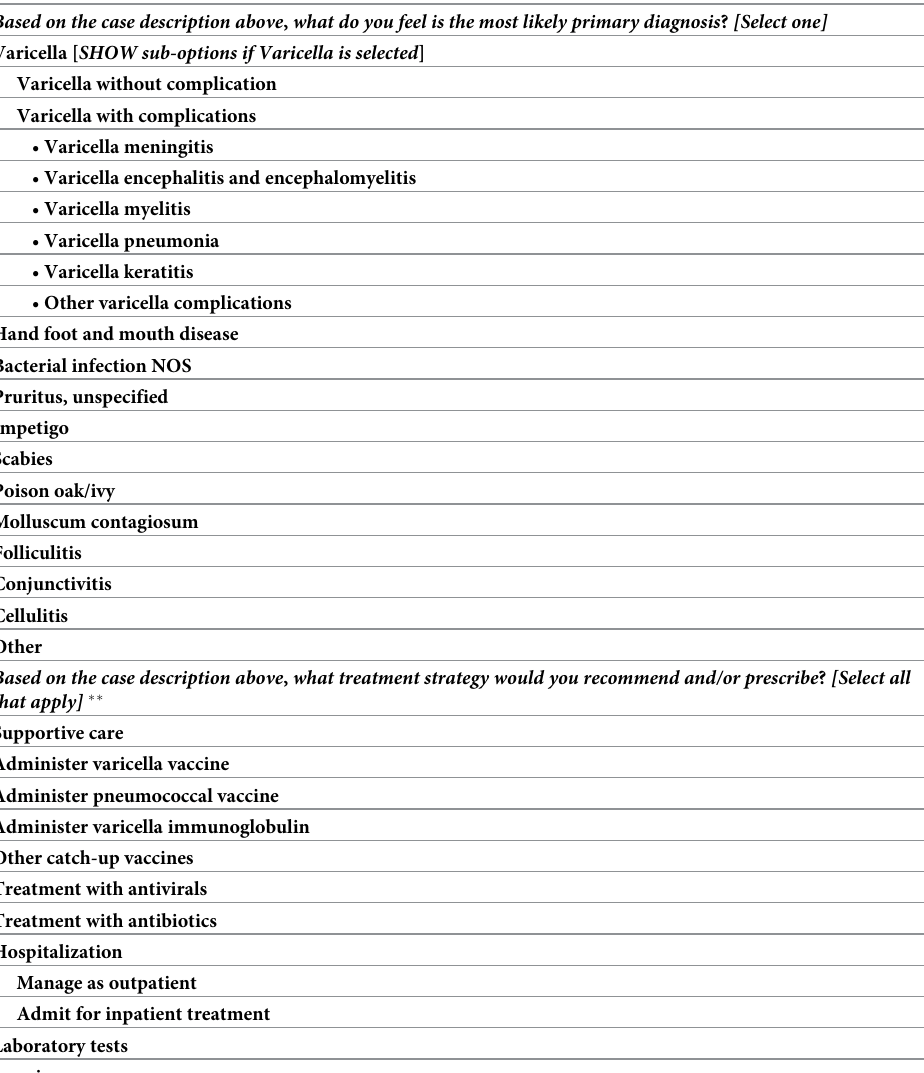
Table 1. a. List of Potential Diagnoses Options. b. List of Potential Management Strategies � . Based on the case description above , what do you feel is the most likely primary diagnosis ? [Select one] Varicella [ SHOW sub-options if Varicella is selected ] Varicella without complication Varicella with